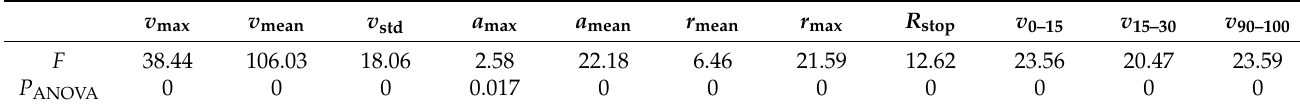
Table 5. Results of the ANOVA of the 11 characteristic parameters.